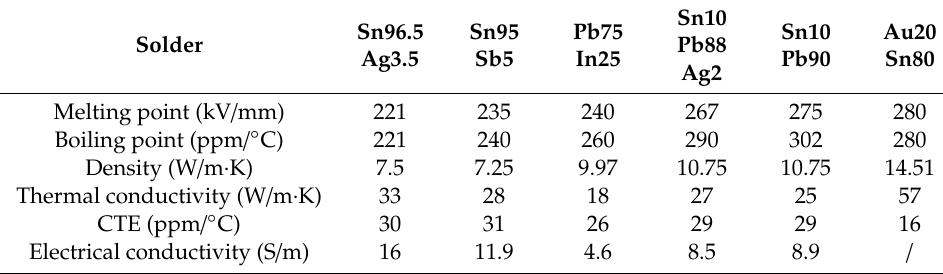
Table 5. The thermal mechanical characteristics of materials for die